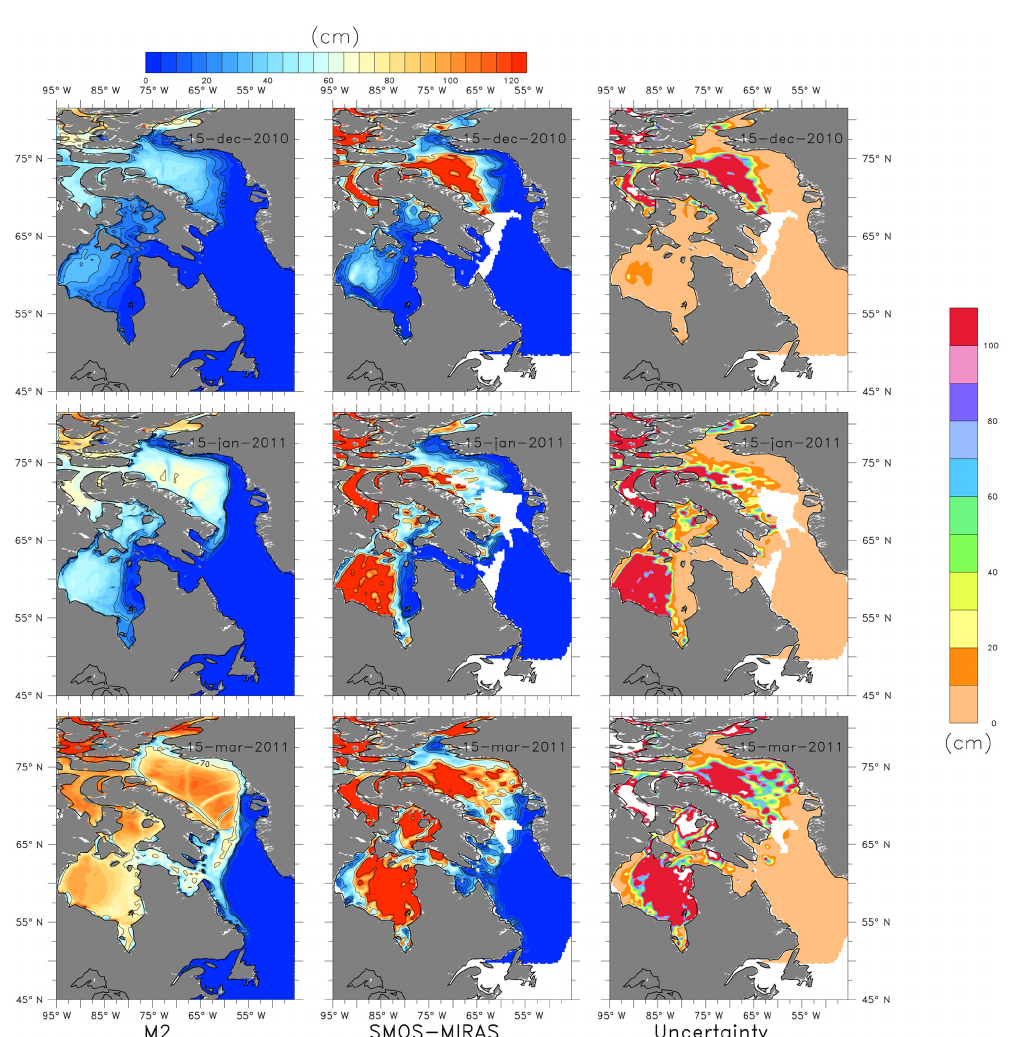
Figure 9. The M2-estimated ice thickness, SMOS–MIRAS-derived ice thickness and the observation uncertainty for 15 December 2010, 15 January and 15 March